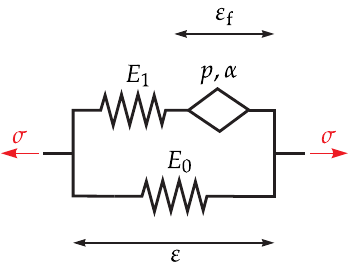
Figure 6. Fractional Zener